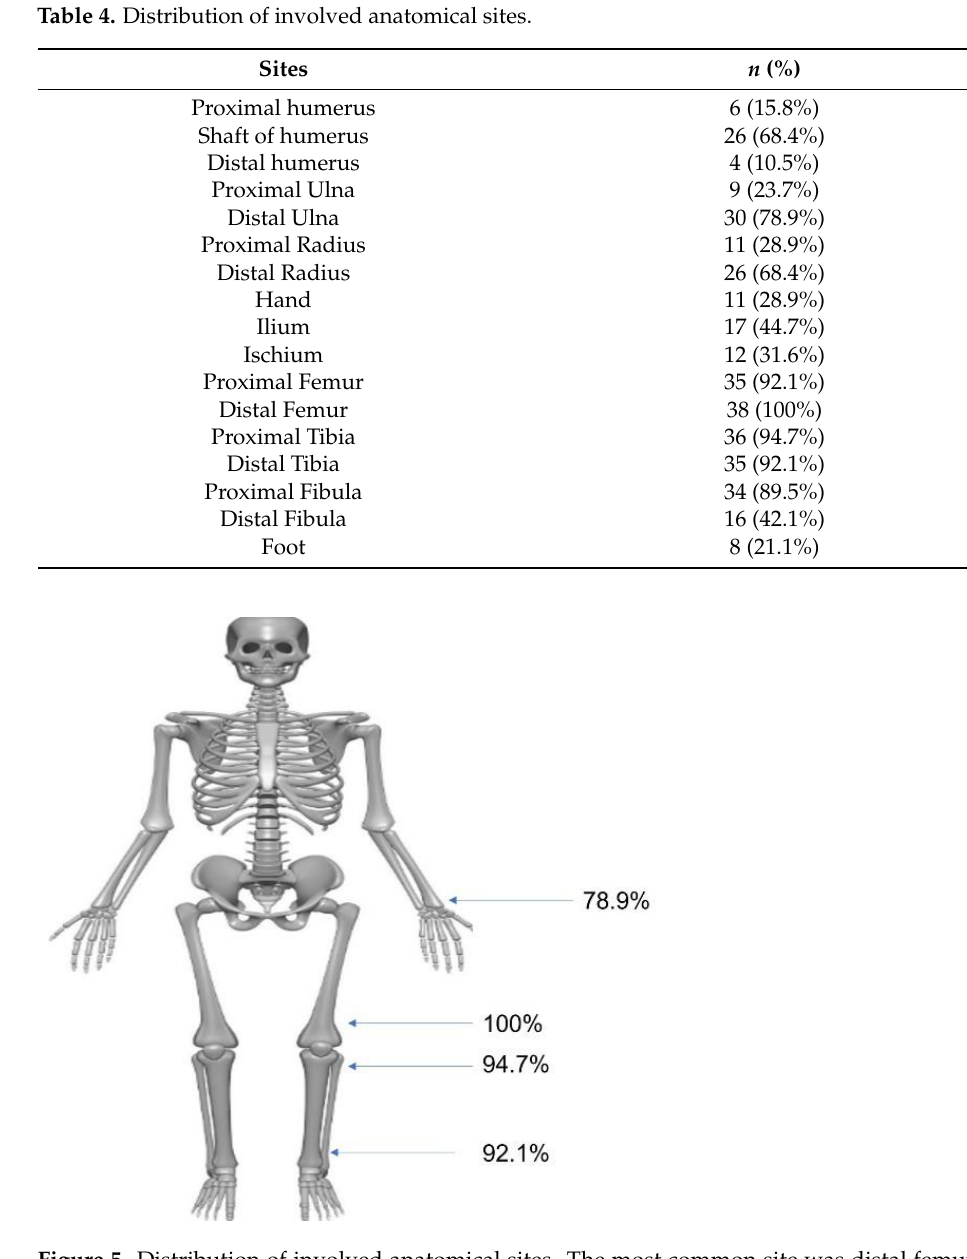
Figure 5. Distribution of involved anatomical sites. The most common site was distal femur and proximal tibia.